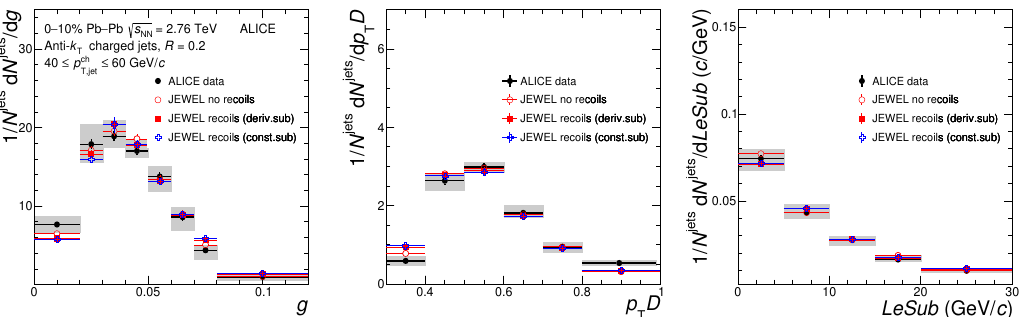
p s NN = 2 : 76 TeV for